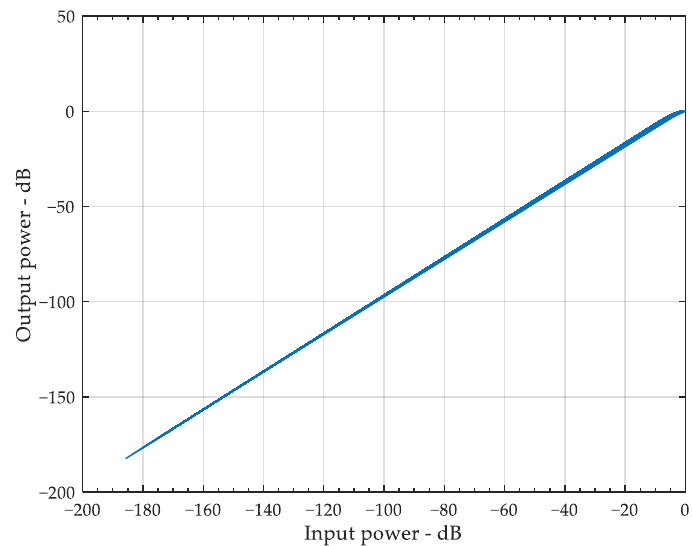
Figure 6. AM / AM characteristic curve of predistorter. Figure 6. AM/AM characteristic curve of predistorter. Figure 6. AM/AM characteristic curve of predistorter.